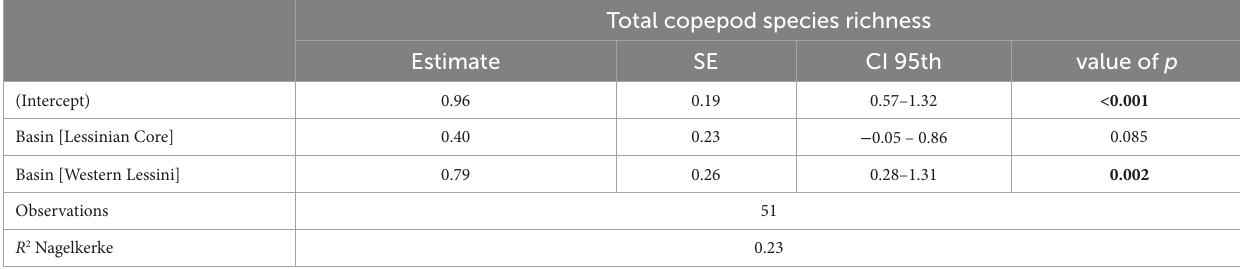
TABLE 2 Results from the refined Generalized Linear Model relating overall copepod species richness to the drainage basin the sampled caves belong to.